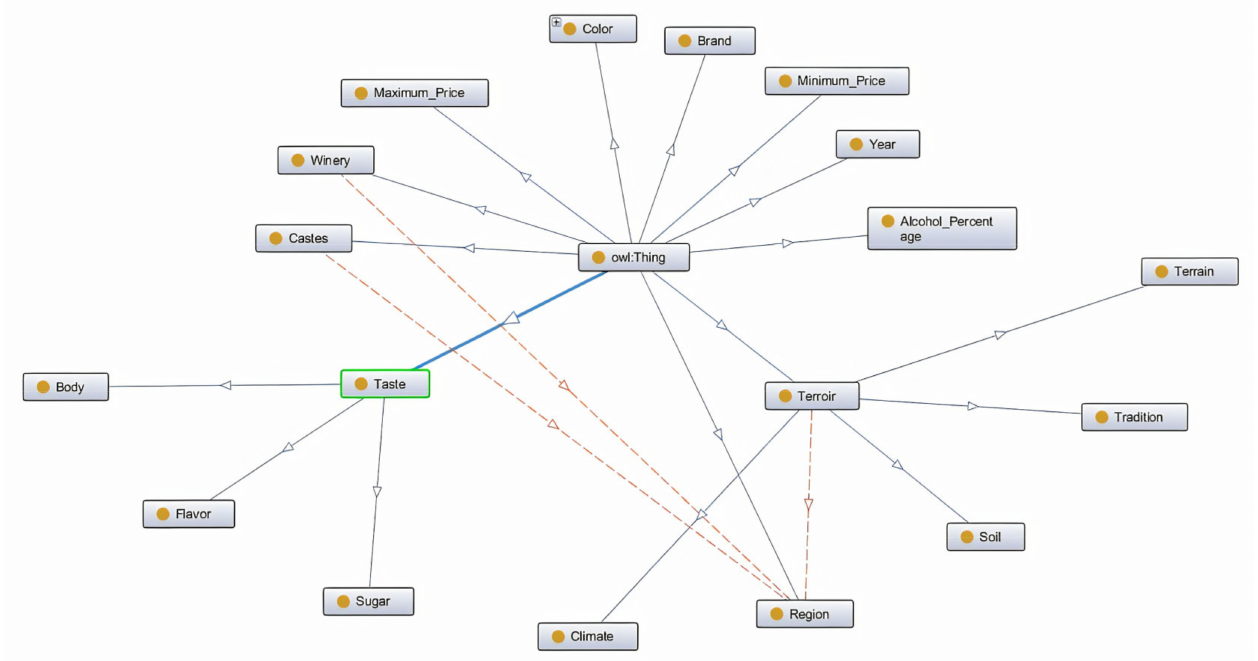
Figure 1. Classes and relations of our wine